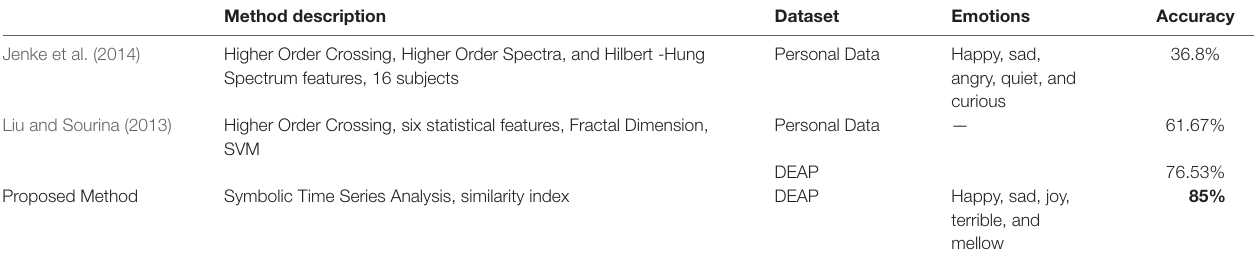
TABLE 4 | Comparison of different studies for emotion recognition using EEG—five groups of